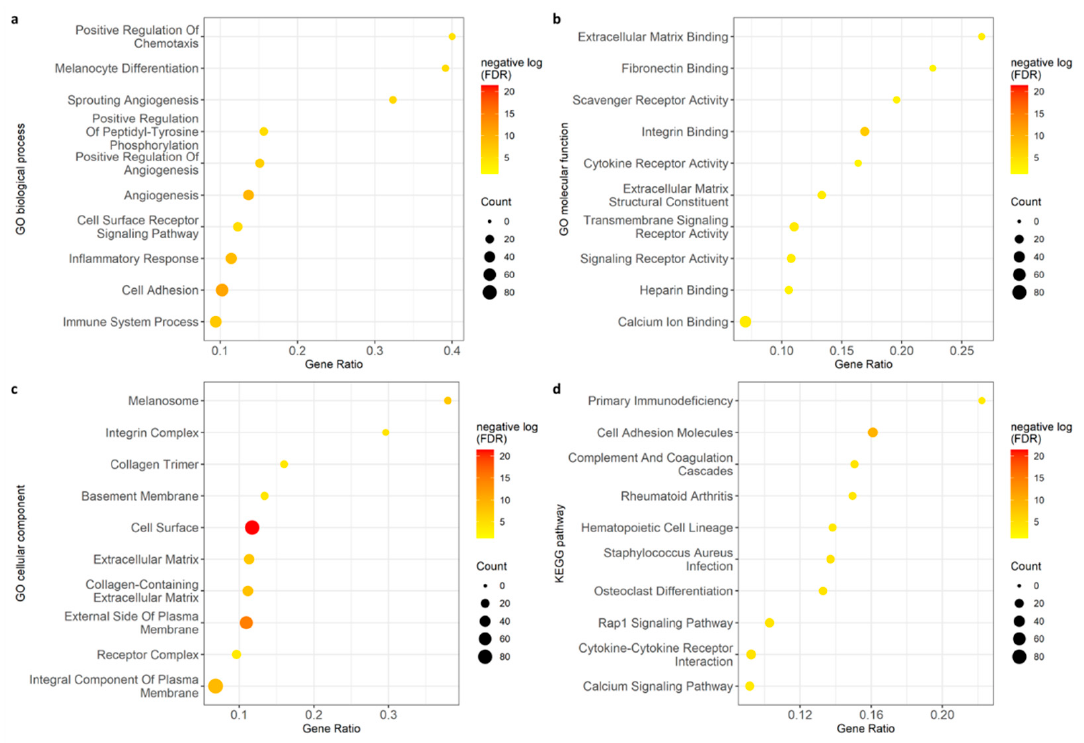
Figure 3. Gene ontology analysis with top 10 results for biological process ( a ), molecular function ( b ), cellular component ( c ), and KEGG pathway ( d ). Enrichment analysis showed multiple biological pathways affected, including angiogenesis and immunological activity.